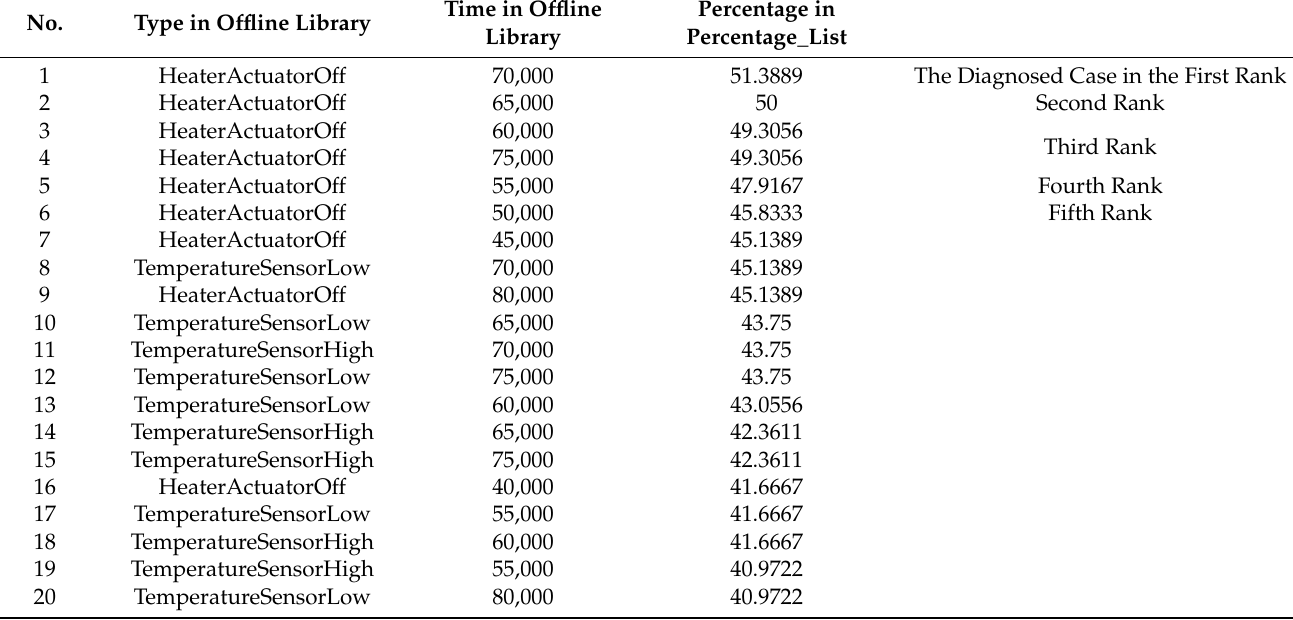
Table 23. Evaluation_List Table for the RealCase